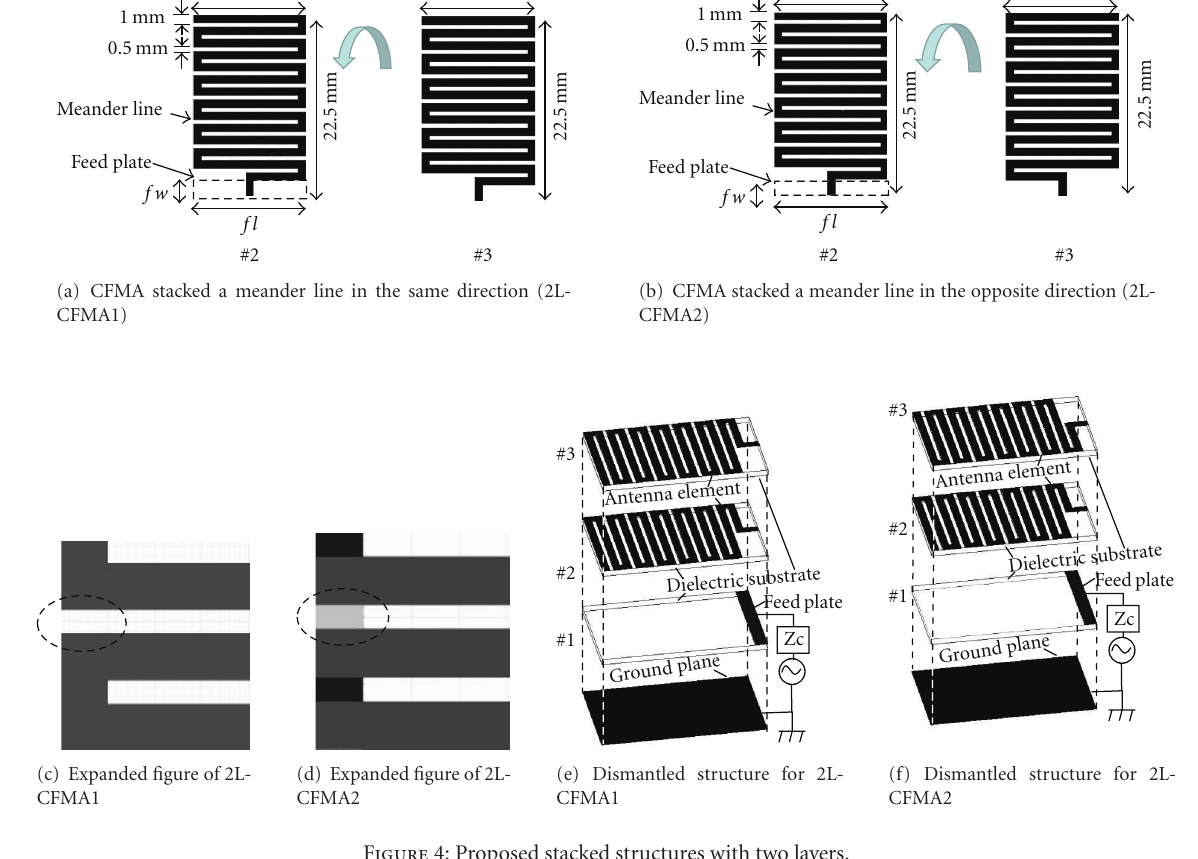
Figure 4: Proposed stacked structures with two